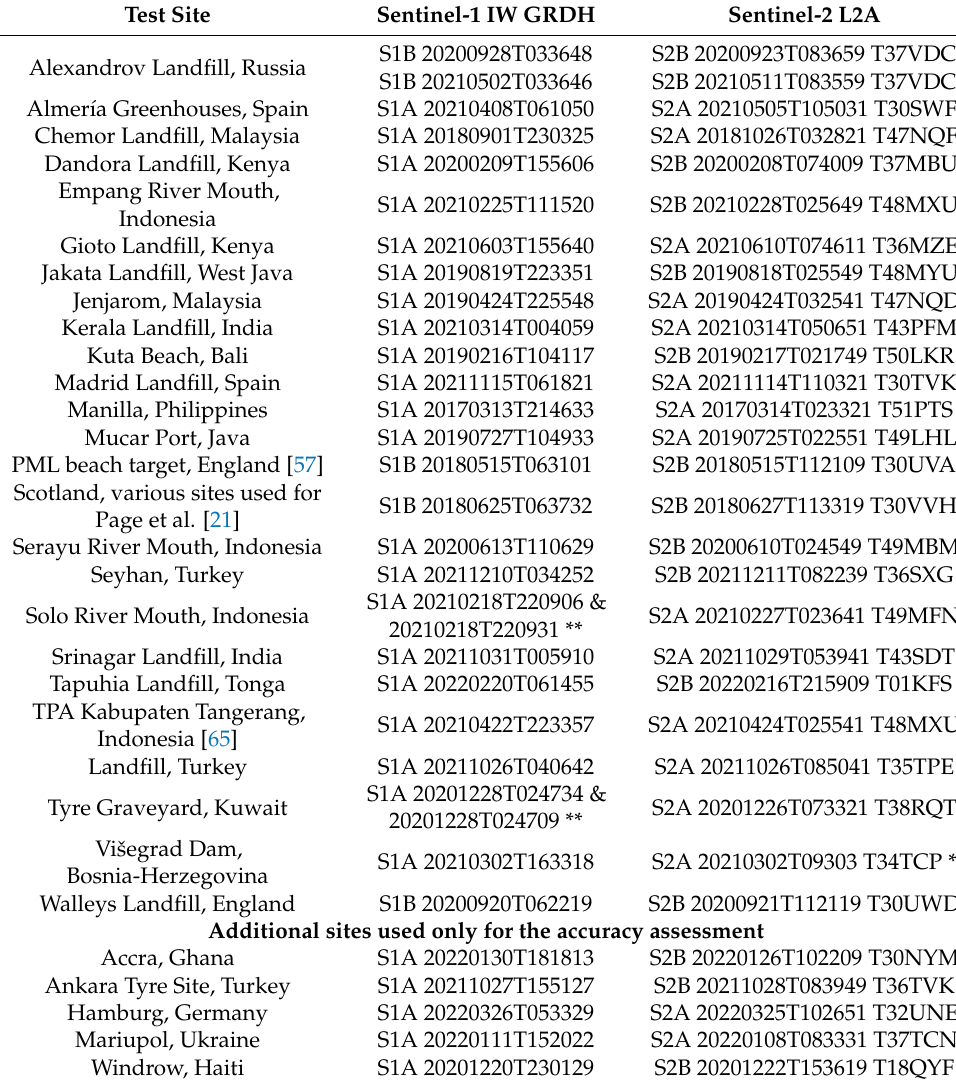
Table A1. Full training/validation dataset in alphabetical order with Sentinel-1 IW GRDH and Sentinel-2 Level 2A files as date/time and (for Sentinel-2)